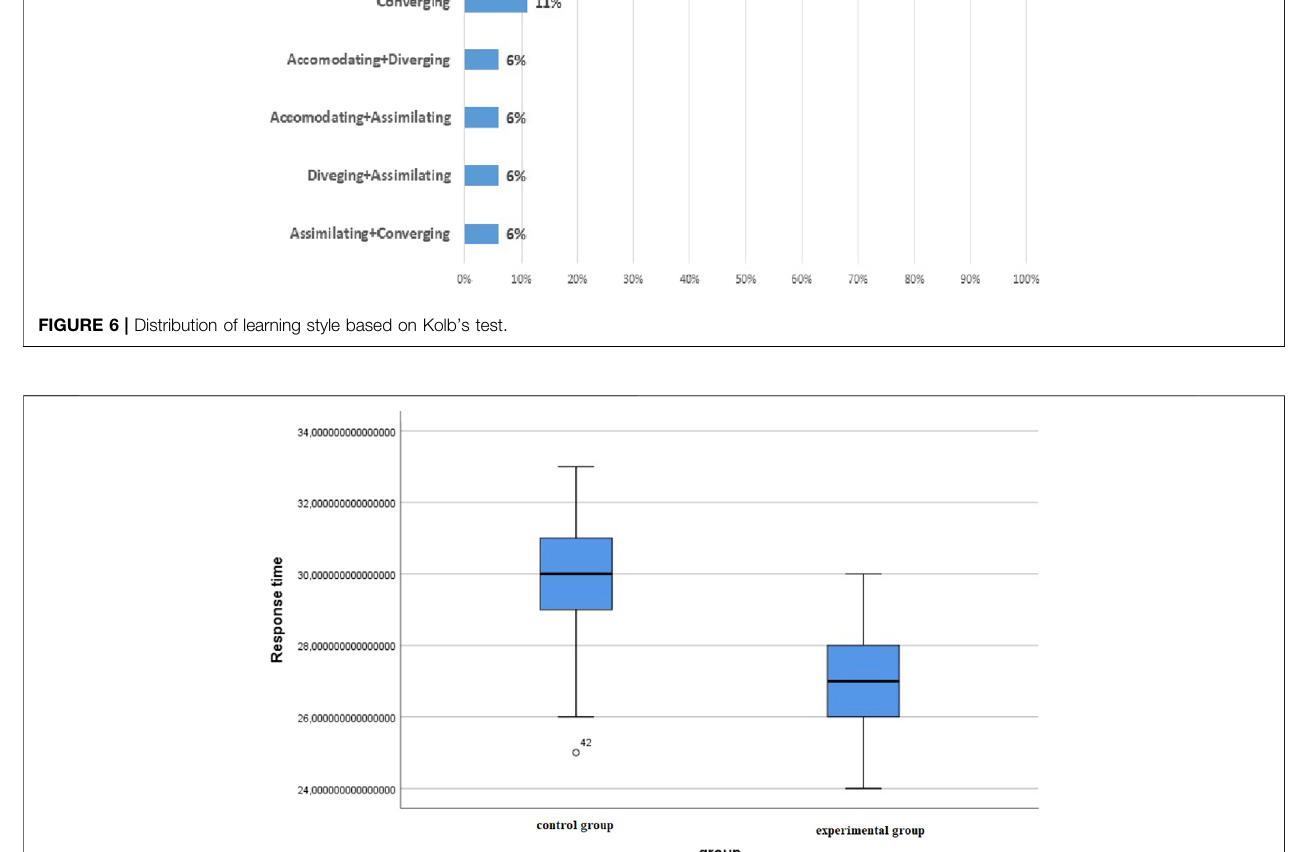
FIGURE 7 | Response